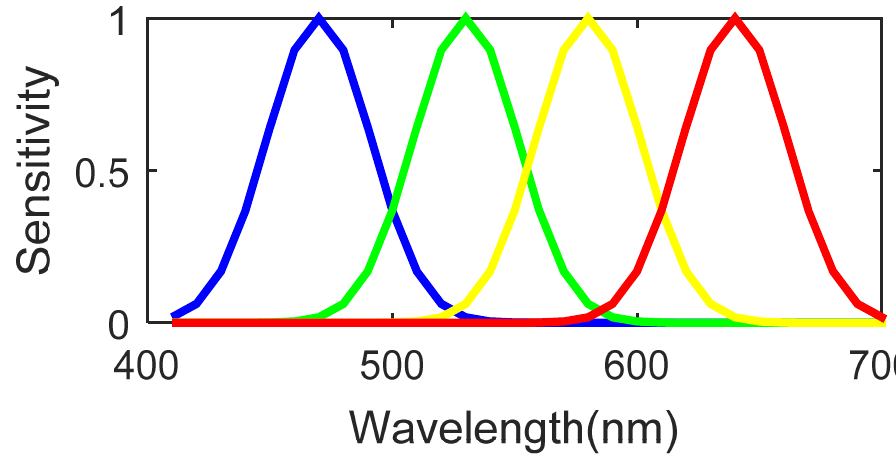
Figure 3. Spectral sensitivity of the 4 ‐ band filters.